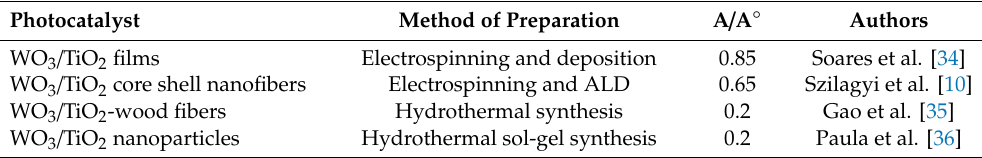
Table 5. Comparison of photocatalytic efficiency of various WO 3 /TiO 2 nanofibers.